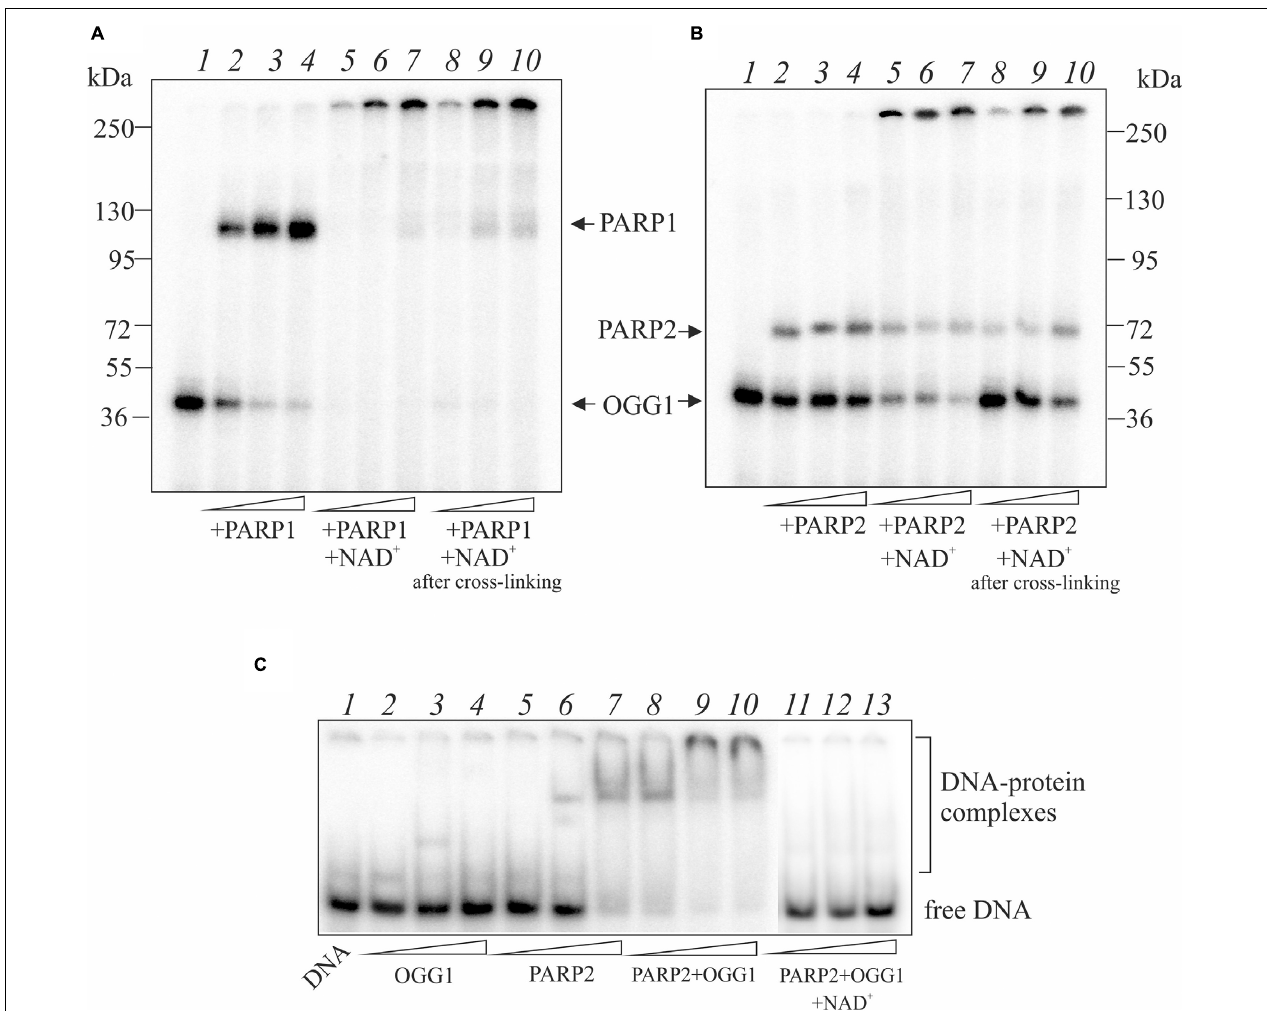
FIGURE 3 | Effect of NAD + addition on the crosslinking of OGG1 to AP site-containing DNA in the presence of PARP1 (A) and PARP2 (B) . Reaction mixture included 10 nM AP site-containing DNA after treatment with UDG, 50 nM OGG1 and different concentrations (50, 100, and 200 nM) of PARP1/2. NAD + at final concentration 1 mM was added to the reaction mixture simultaneously (lanes 5–7) or after incubation of OGG1 with PARP1/2 for 10 min (lanes 8–10). The EMSA analysis of ternary OGG1-PARP2-DNA complex formation (C) . AP-DNA after treatment with UDG was titrated by OGG1 (50, 100, and 200 nM) in the absence (lanes 2–4), in the presence of 100 nM PARP2 (lanes 8–10) or 100 nM PARP2 and 1 mM NAD + (lanes 11–13). Lanes 5–7 – AP-DNA titration with PARP2 (50, 100, and 200 nM) in the absence of OGG1. Lane 1 is DNA control.